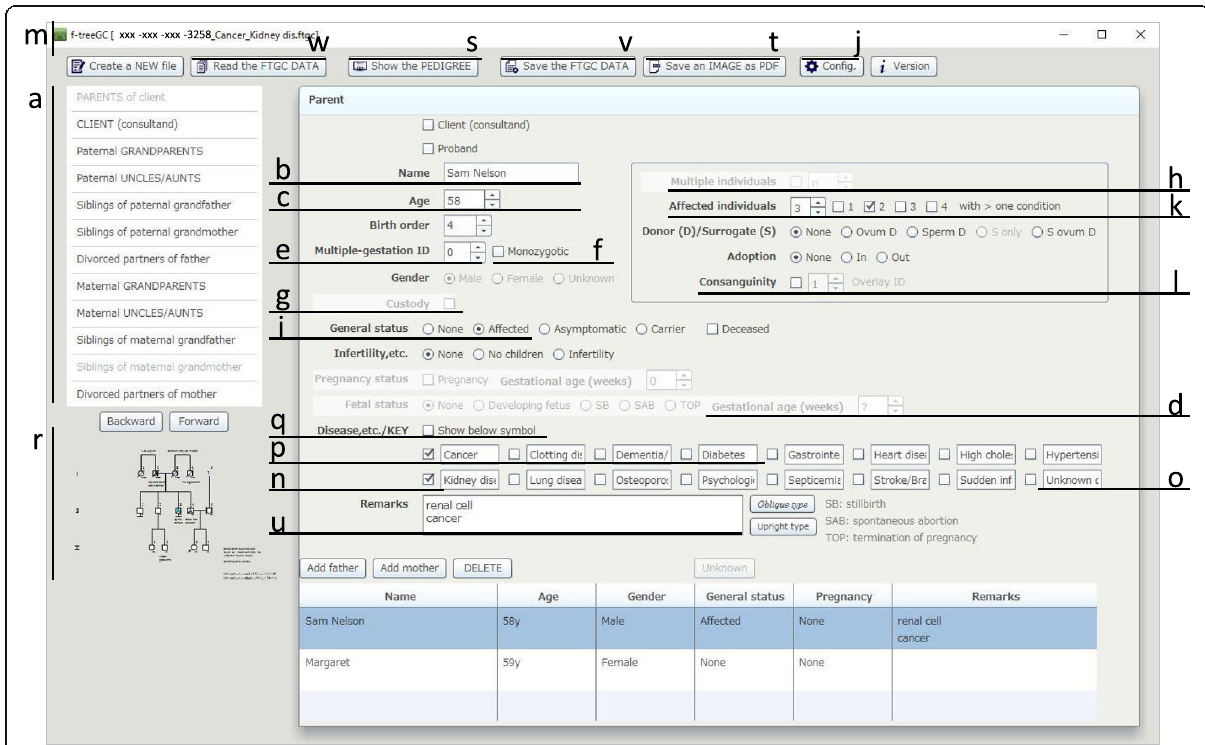
Fig. 1 Information entry screen of f-treeGC; information for three generations is required to create the pedigree ( a ). The genealogical information requested includes name ( b , u ), age ( c , d ), gender, general status [affected ( i , j , k ), asymptomatic/presymptomatic carrier, carrier, or deceased], infertility status, pregnancy status, fetal status, and disease status ( m , n , o , p , q , t ) of individuals belonging to three generations. In addition, client, proband and birth order information, including multiple gestation ( e , f ), custody ( g ), multiple individuals ( h ), donor or surrogate, adoption, and consanguinity ( l ) information may be inserted. The chart-creation process is visible for inspection on the lower left side of the f-treeGC screen in real time ( r ). A multiple-choice questionnaire for genetic information is filled out by an interviewer or the client; then, f-treeGC automatically creates a pedigree chart ( r , s , t , v , w